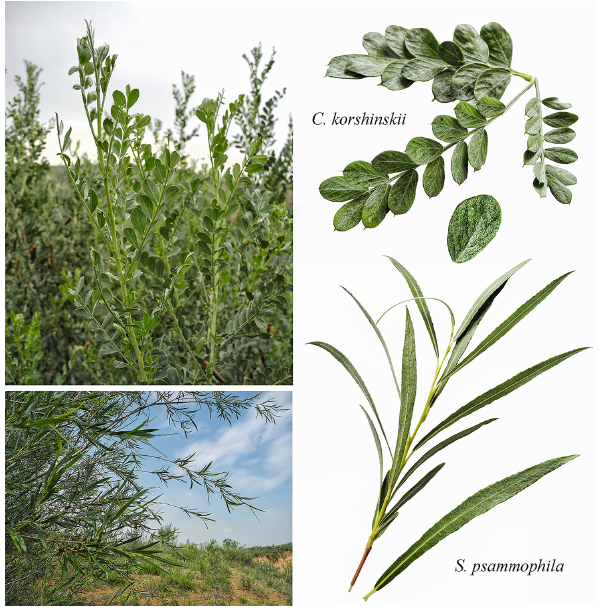
Figure 6. Comparison of leaf morphologies of C. korshinskii and S. psammophila